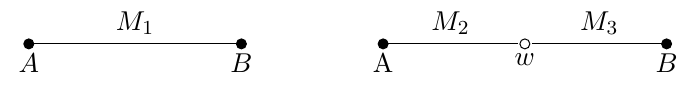
(cid:6) k (cid:7) + 1- 2